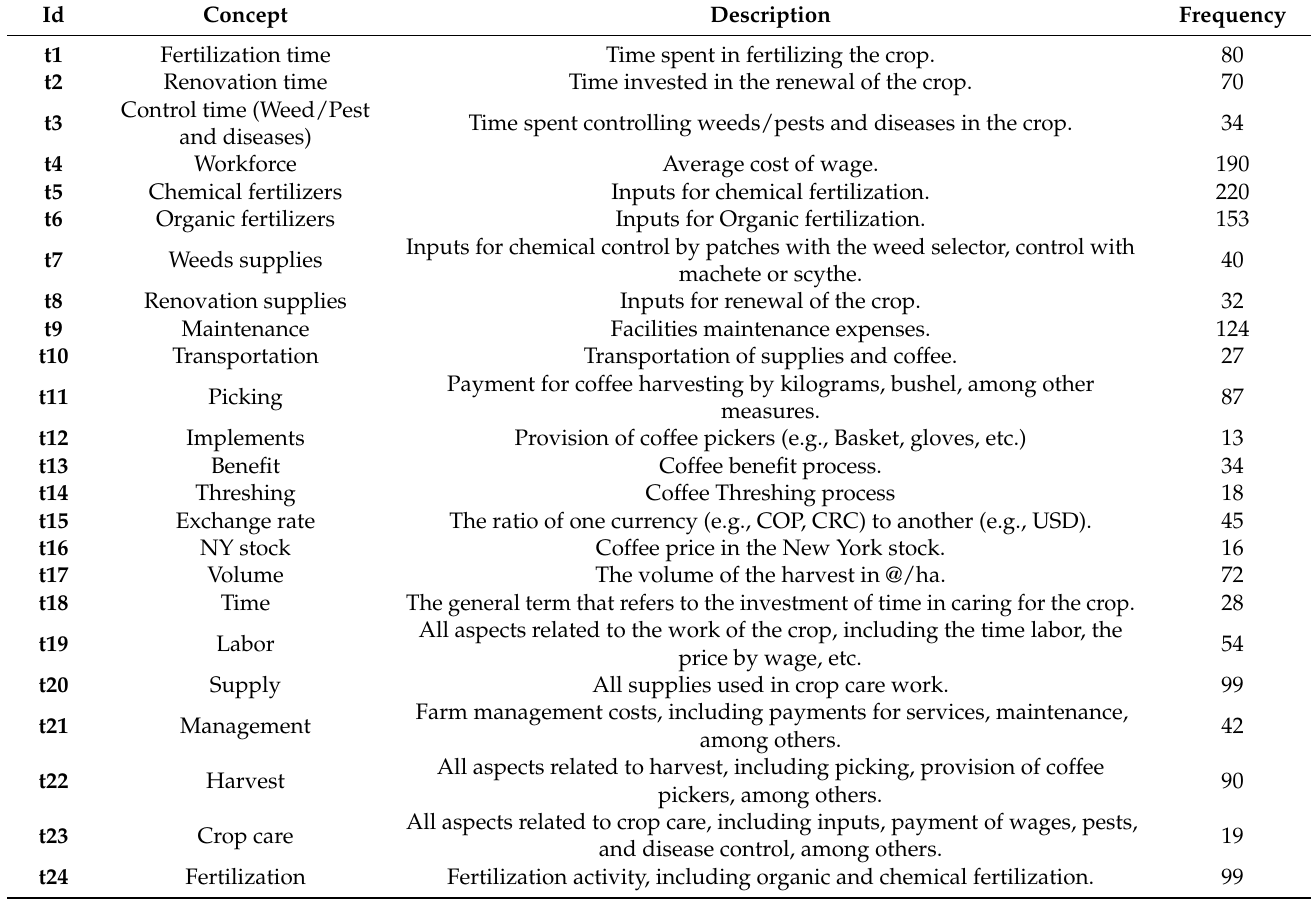
Table 2. HMP-Coffee concepts list. The id column contains an identifier by the concept. The concept column includes the 24 HMP-Coffee brainstorming terms, the description column includes the meaning of the concept in coffee production context and frequency column, the number of occurrences by the